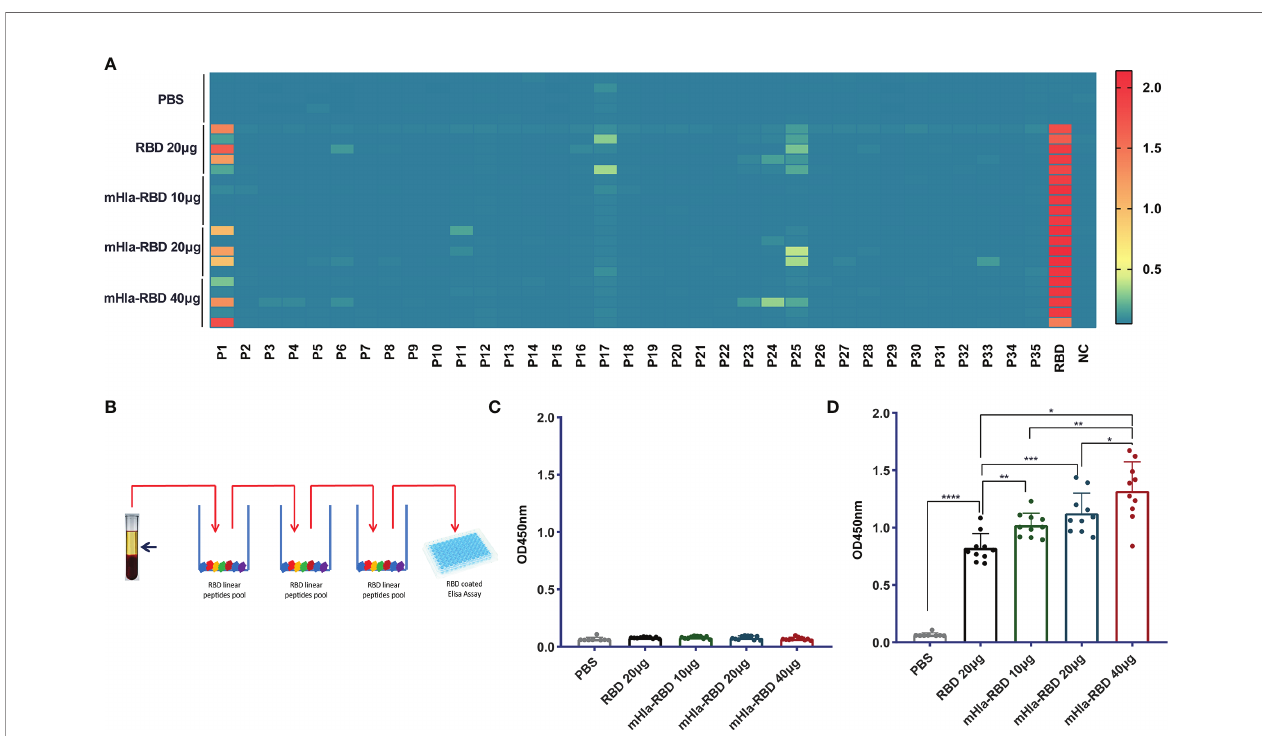
FIGURE 4 | Detect of linear and conformational epitope antibodies. (A) Heatmap of antibodies recognizing 18-mer overlapping peptides from immunized BALB/c mice (n=5). (B) Schematic diagram of elimination of antibodies recognizing RBD linear epitopes. (C) Assessment of antibodies recognizing the RBD linear peptide pool after absorption. (D) Assessment of antibodies recognizing RBD conformational epitopes after absorption. One-way ANOVA with Tukey ’ s multiple comparisons, * p < 0.05, ** p < 0.01, *** p < 0.001, **** p <